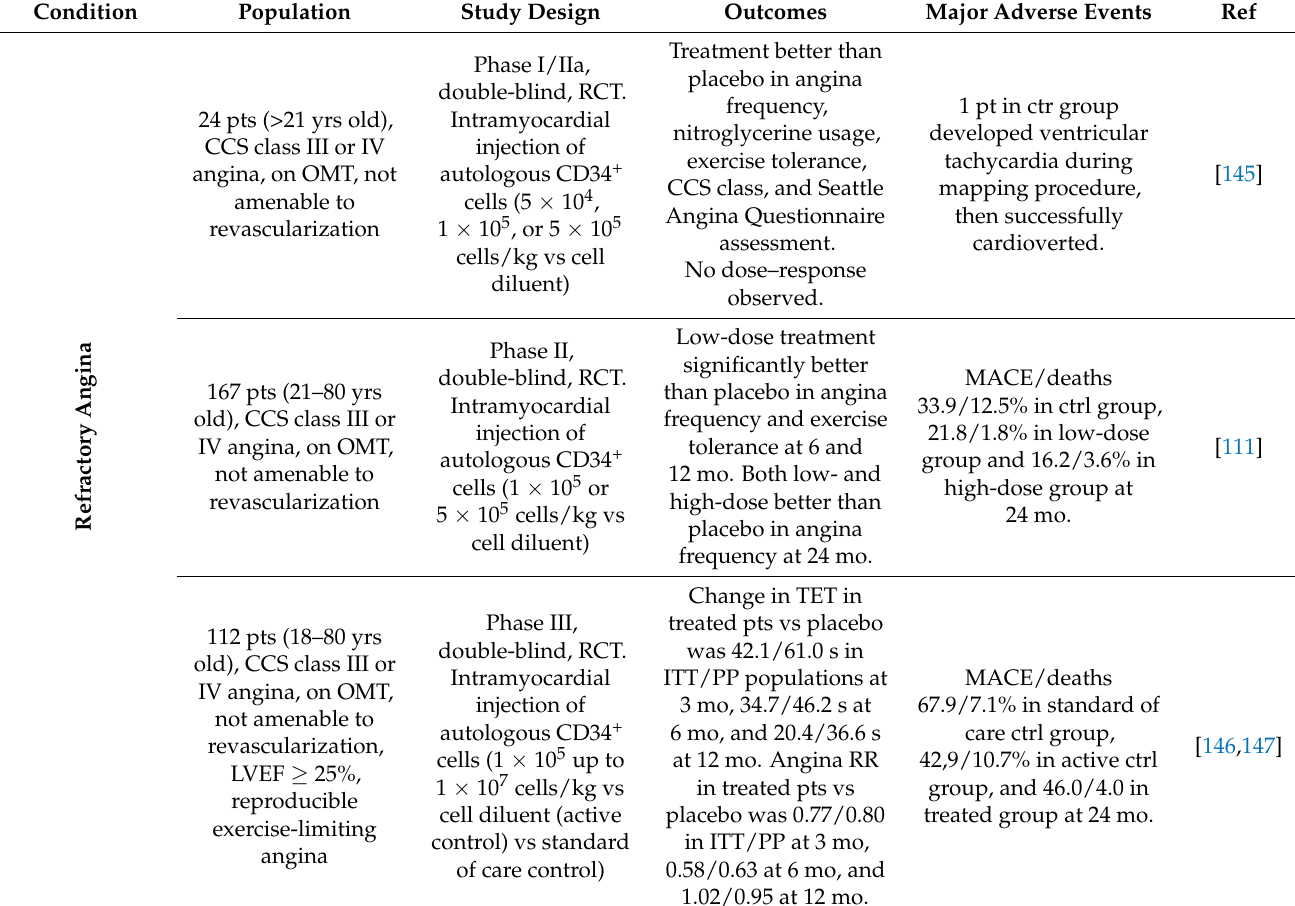
Table 1. Clinical trials on refractory